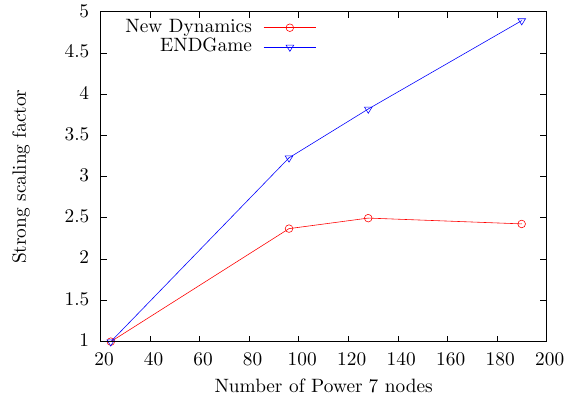
Figure 1. Strong scaling plot simulations using the ENDGame and New Dynamics dynamical cores (both using GA3.1 physics and full-operational diagnostic and input/output loads) at N768 resolu- tion on an IBM Power 7 supercomputer. Each Power 7 node con- tains 32 compute